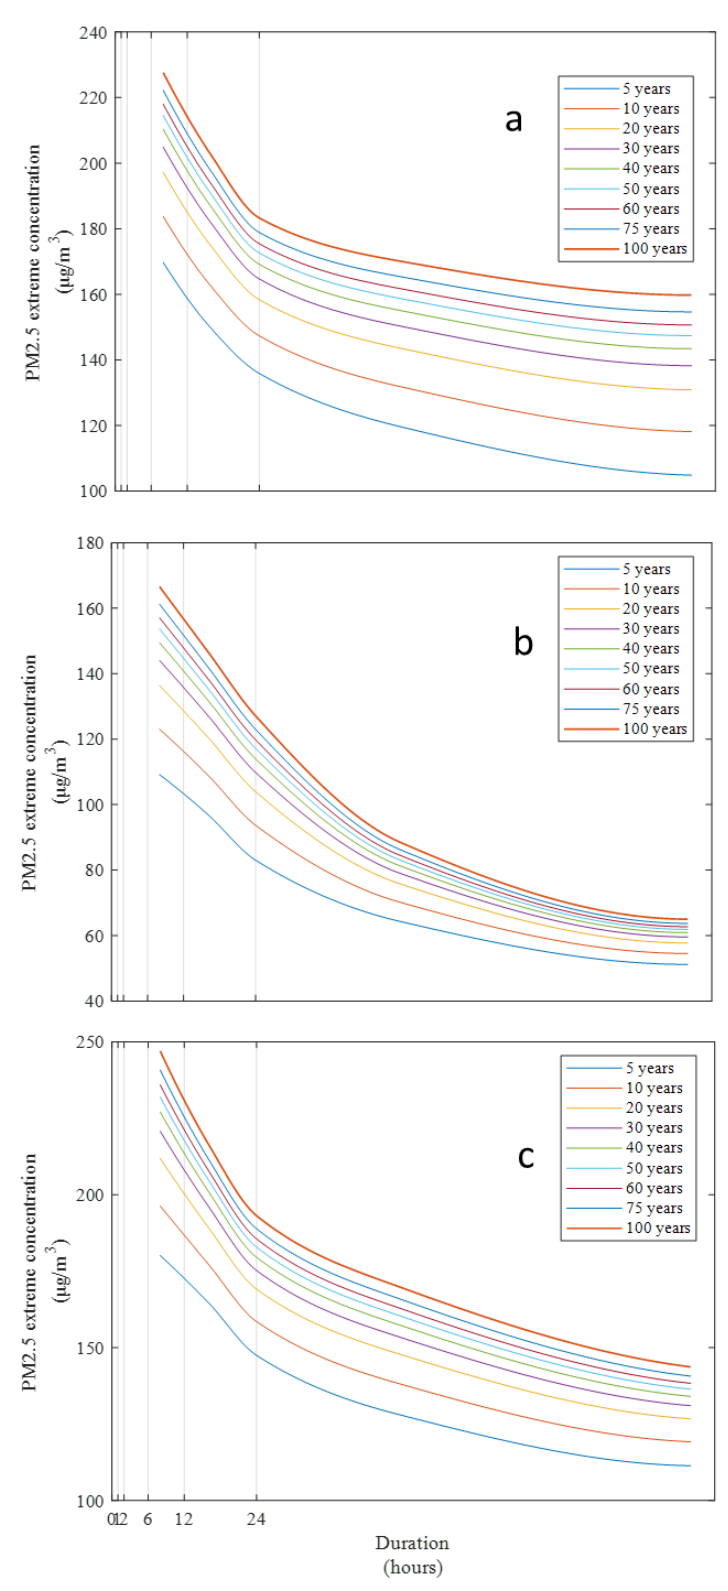
Figure 4. CDF curves in ( a ) Erlin, ( b ) Hualien, and ( c ) Xiaogang for the duration of 8–96 h.